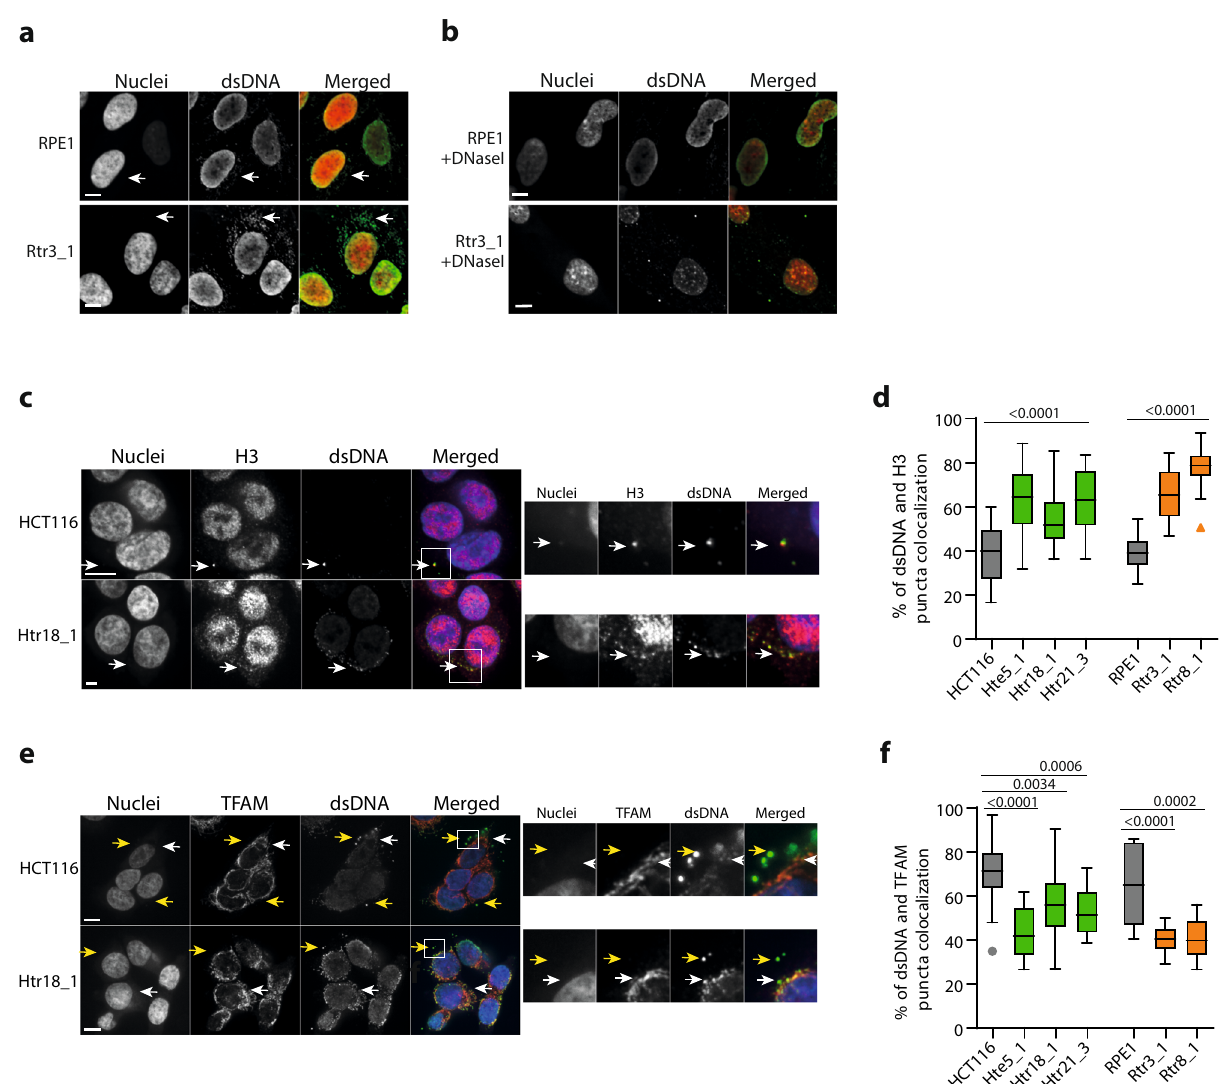
Fig. 2 Increased presence of cytoplasmic dsDNA in cells with extra chromosomes. a Examples of immuno fl uorescent images of nuclear and cytoplasmic dsDNA. White arrows point to the dsDNA staining in the cytoplasm. b Staining of cytoplasmic dsDNA in cells treated with DNase I. c Immuno fl uorescence images of dsDNA colocalization with H3 (white arrows). d Quanti fi cation of the percentages of dsDNA puncta copositive for H3. e Immuno fl uorescence of dsDNA with TFAM colocalization (white arrows). Yellow arrows indicate dsDNA puncta negative for TFAM. f Quanti fi cation of the percentages of puncta positive for both dsDNA and TFAM. Individual measurements, mean values, p -values, and standard deviations are shown in the plots, statistical evaluation is summarized in Supplementary table 4, and source data is available in Supplementary Data 5. At least 20 cells were analyzed for the puncta quanti fi cation for each cell line. Unpaired t -test was used for statistical analysis. Scale bar 10 µ